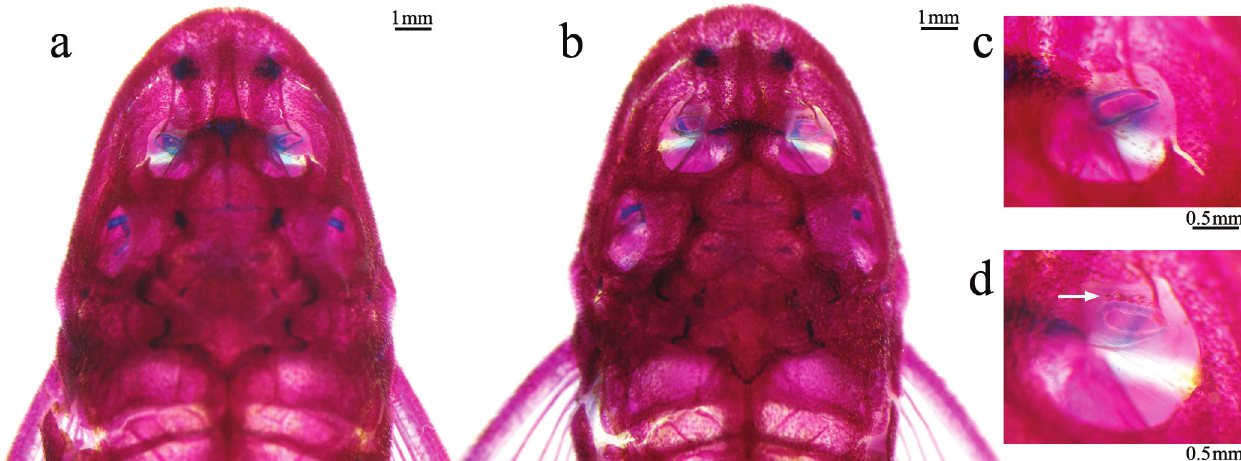
DZSJRP 12332, paratype, female, 30.8 mm SL. b , d . DZSJRP 12332, paratype, male, 30.4 mm SL. Arrow indicates the single row of odontodes in front of naris of male.